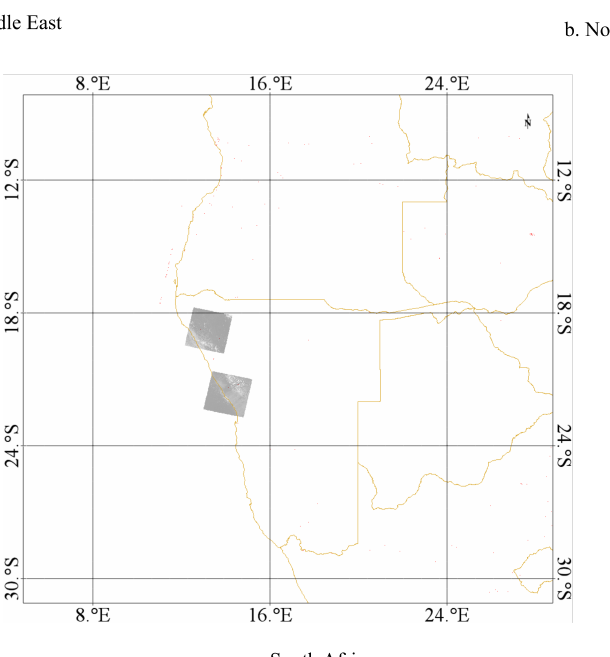
Figure 2. GC-36 stable dark target pixels in red color. WRS-2 path/row images footprint for L8 in the different continents: ( a ) Middle East, ( b ) South Africa, and ( c ) North